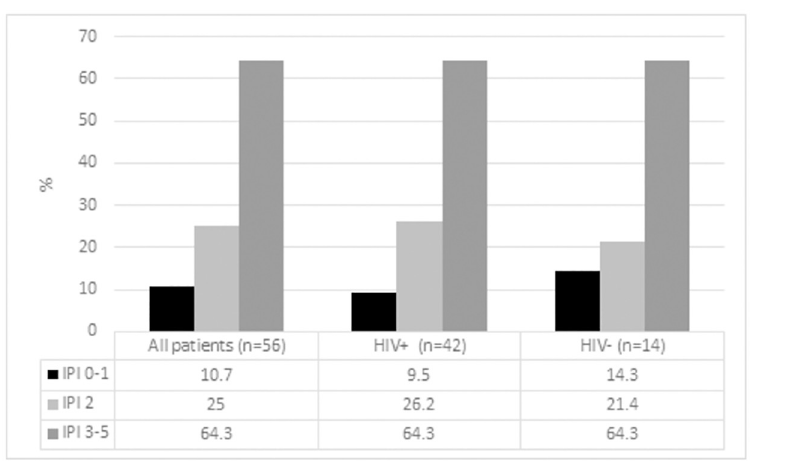
Fig 2. IPI score according to HIV-status.